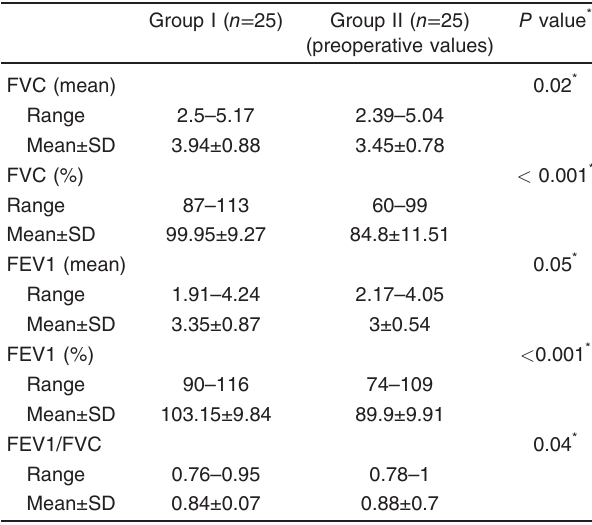
Table 3 Pulmonary function tests values: preoperative pulmonary function test values of group I versus group II Group I ( n = 25)